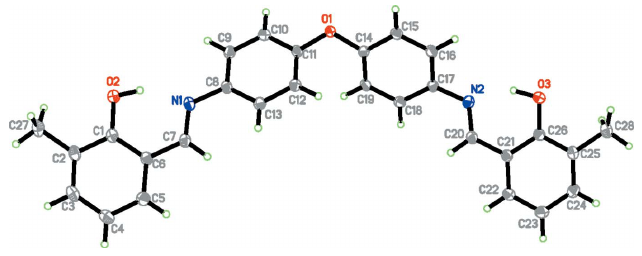
Figure 1 The title molecule with the atom-labelling scheme and 50% probability displacement